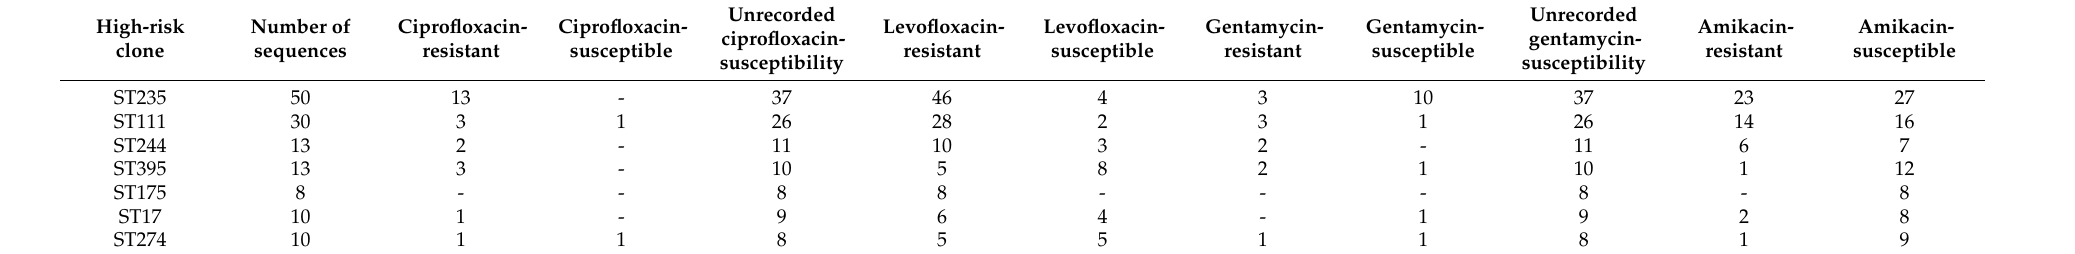
Table 1. Summary of sequences belonging to high-risk clones with their corresponding quinolone and aminoglycoside susceptibility.